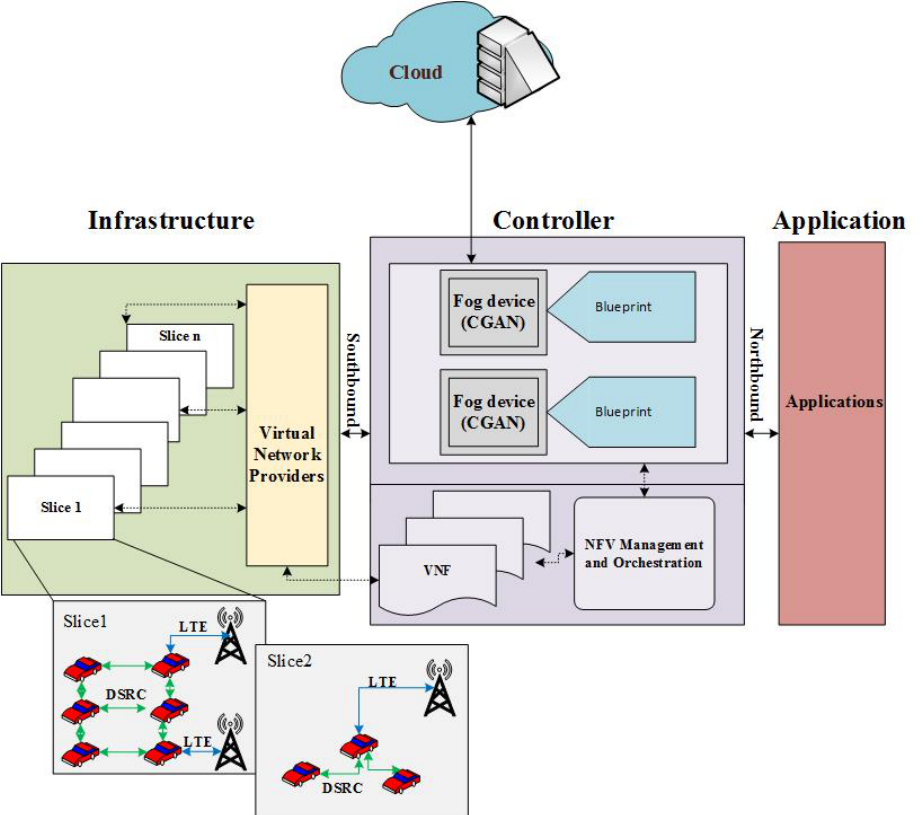
Figure 5. An intelligent hybrid CGAN-Software-Defined Network (CGAN-SDN) architecture for